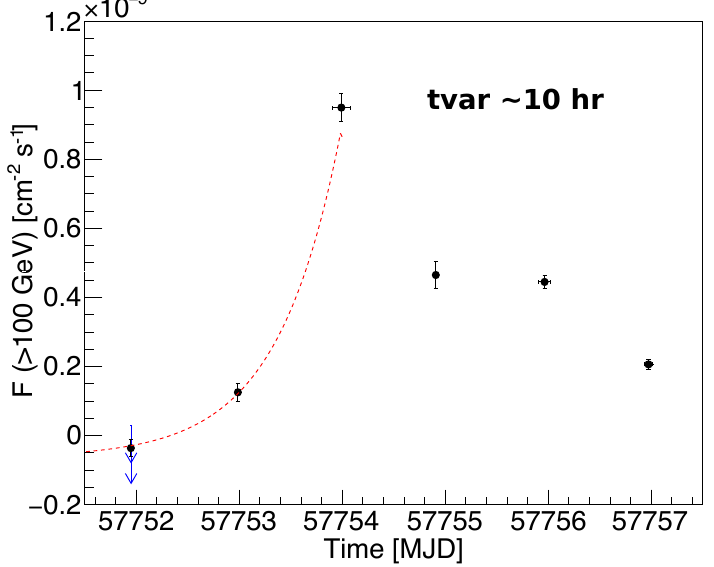
Figure 6. TeV light curve of 3C 84 observed by the MAGIC telescope [4]. The fastest flare observed around January 01, 2017 has a flux doubling timescale of shown in Figure